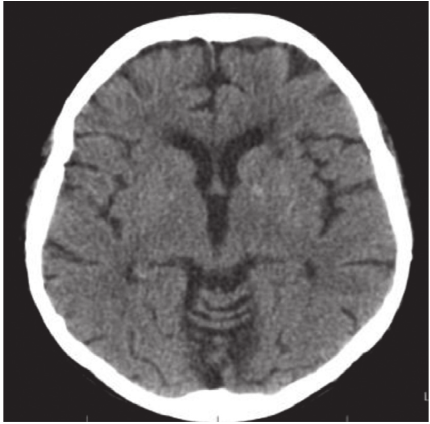
Figure 1: Cranial computed tomography showing previous left lacunar stroke.